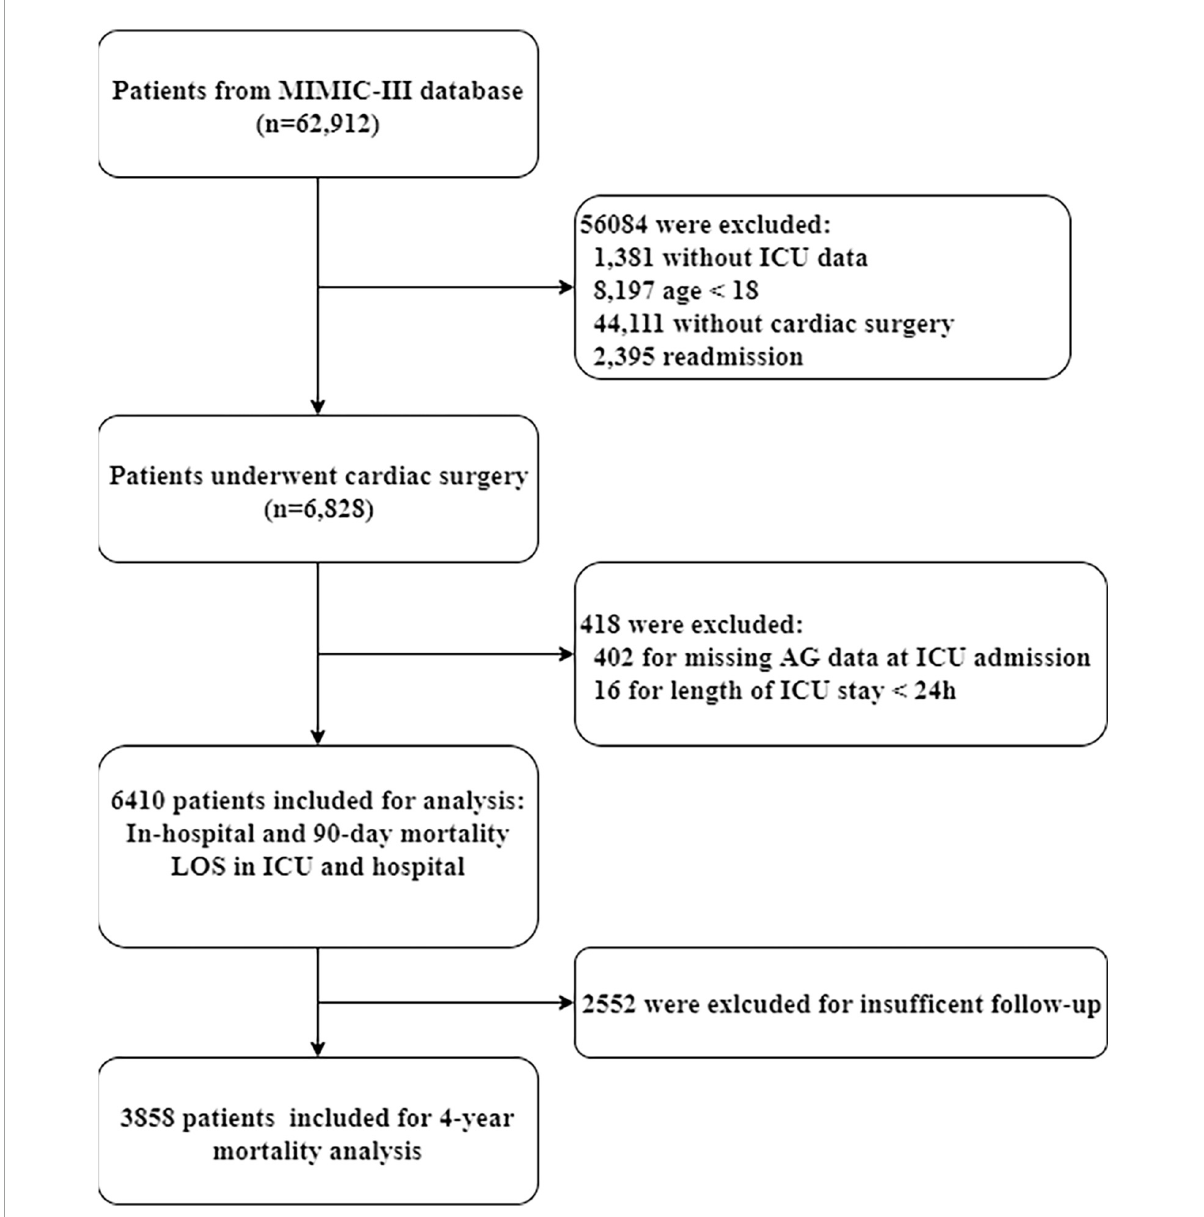
FIGURE1 The flowchart of study cohort selection. LOS, length of stay.